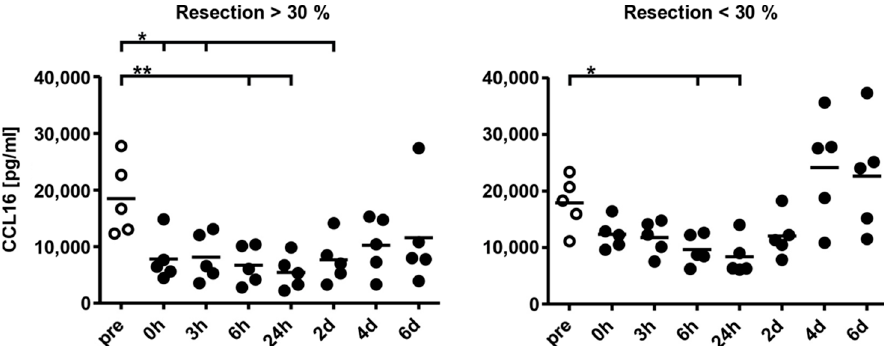
Figure 3. The liver is the primary source of CCL16 in human serum. CCL16 protein abundance was measured in the sera of patients who underwent liver resection. One group represents a removal of more than 30% of the liver mass, the other group had less than 30% removed. Sera were taken at the end of surgery (0 h) and at various time points thereafter and analysed by ELISA. Data are represented by individual values as well as means for each time point. A Mann–Whitney U test was performed to analyse statistical differences (*, p < 0.05; **, p < 0.01).